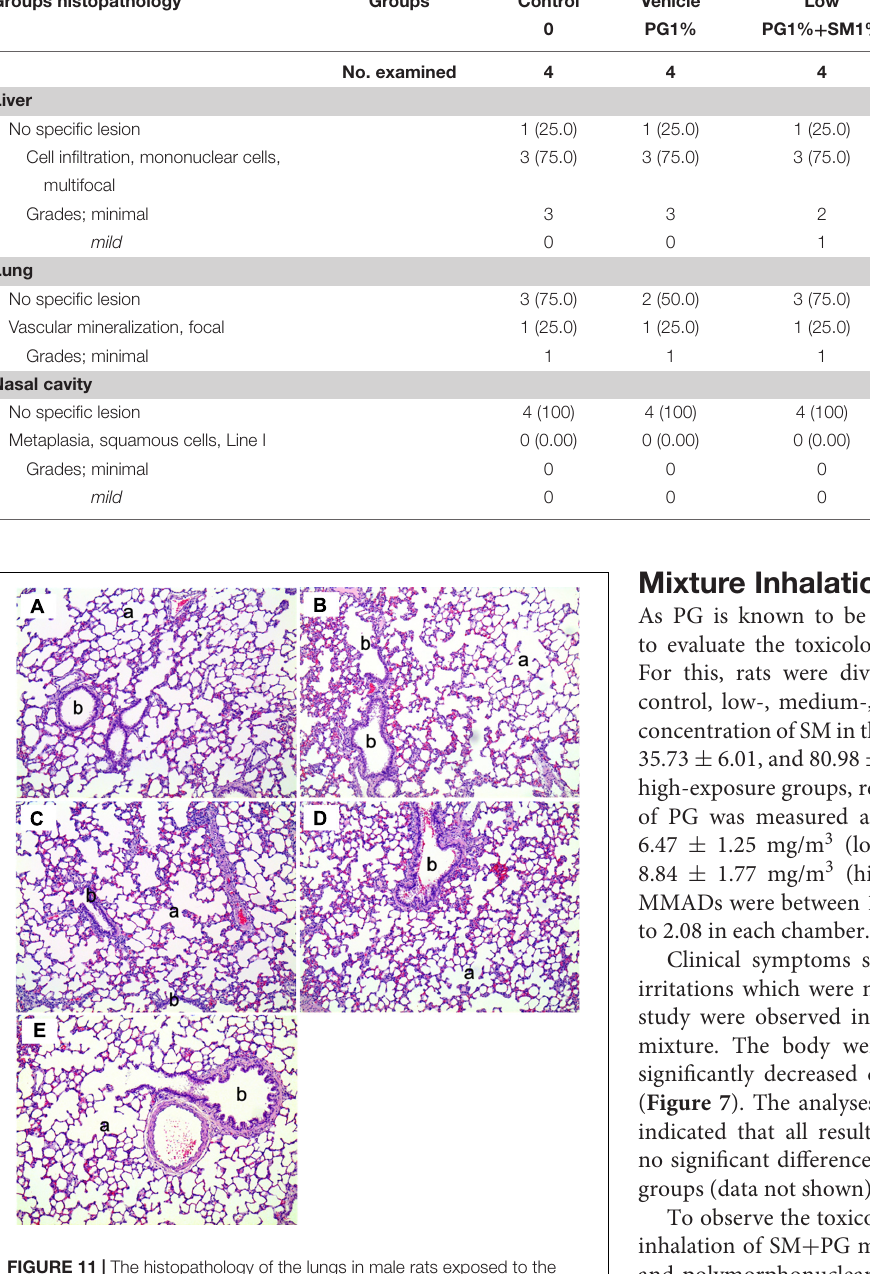
TABLE 2 | The summary of the histopathological results of rats repeatedly inhaled with the mixture of SM and propylene glycol (PG). Groups histopathology